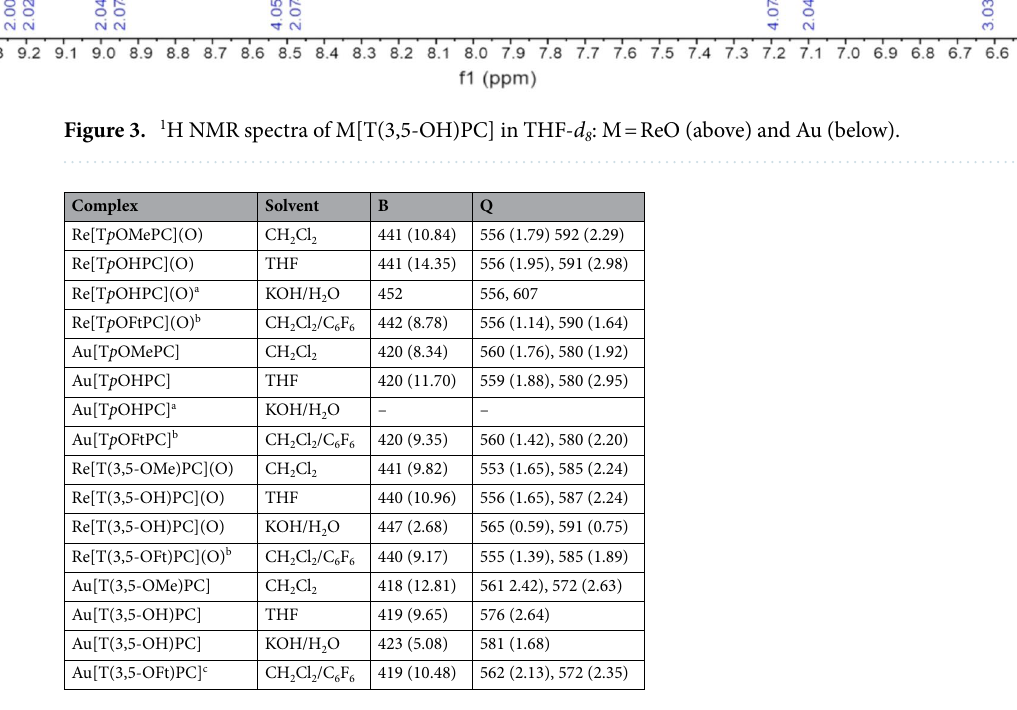
Table 1. UV–vis absorption maxima ( λ , nm) and extinction cofficients [ ε × 10 –4 (M −1 cm −1 )]. a Poor solubility did not allow a determination of spectral data, in part or in whole. b Spectra were acquired in CH 2 Cl 2 containing a small amount of hexafluorobenzene (C 6 F 6 ).